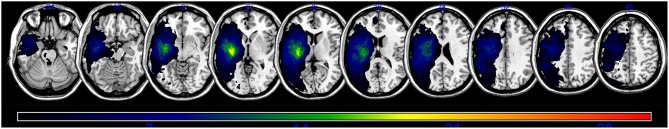
A lesion overlap map of all subjects (n = 31). The color spectrum indicates the frequency of overlap.